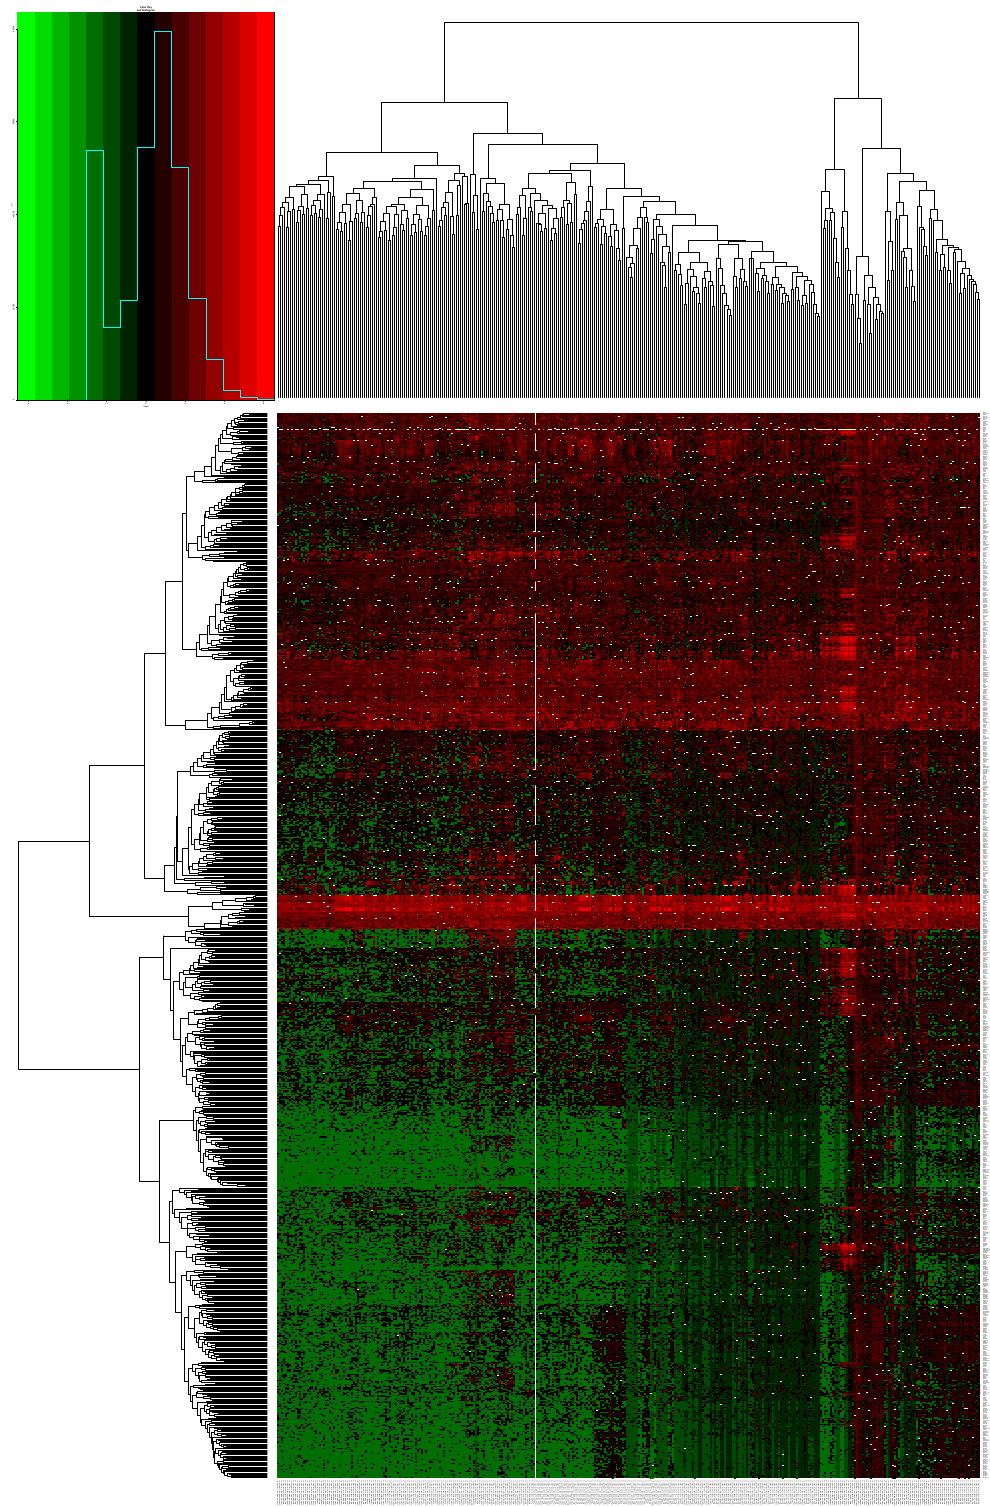
Figure S2: Heat map of DEGs between low - and high - risk score phenotypes of gastric cancer